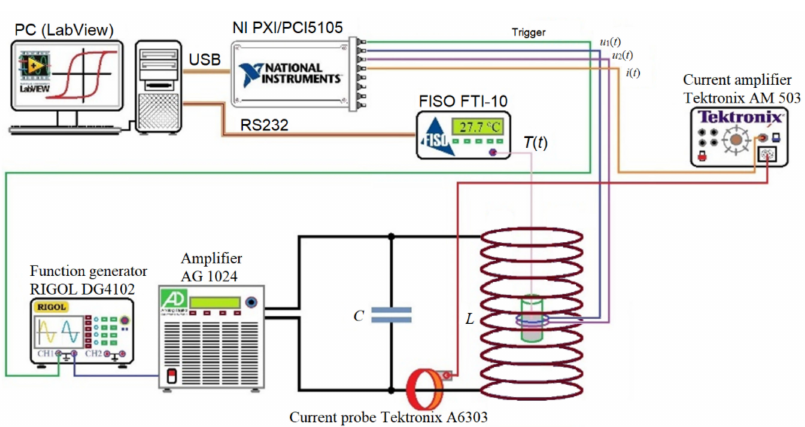
Figure 1. Schematic representation of the measurement system